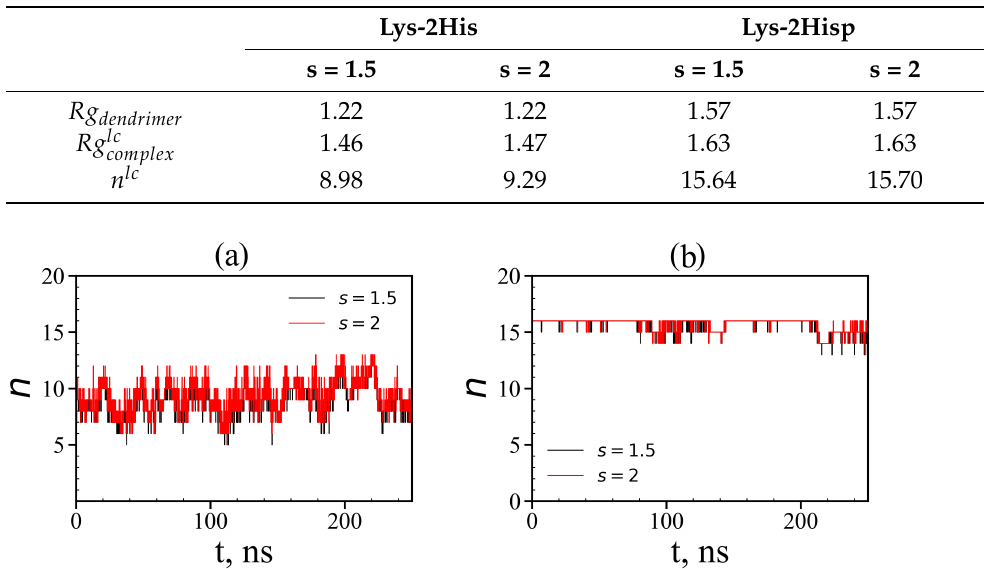
Figure 16. Time dependences of the number of tetrapeptides in complexes (local criteria): ( a ) Lys– 2His + 16AEDG; ( b ) Lys–2Hisp + 16AEDG (two different value of distances s = 1.5 and 2 are used as dendrimer or